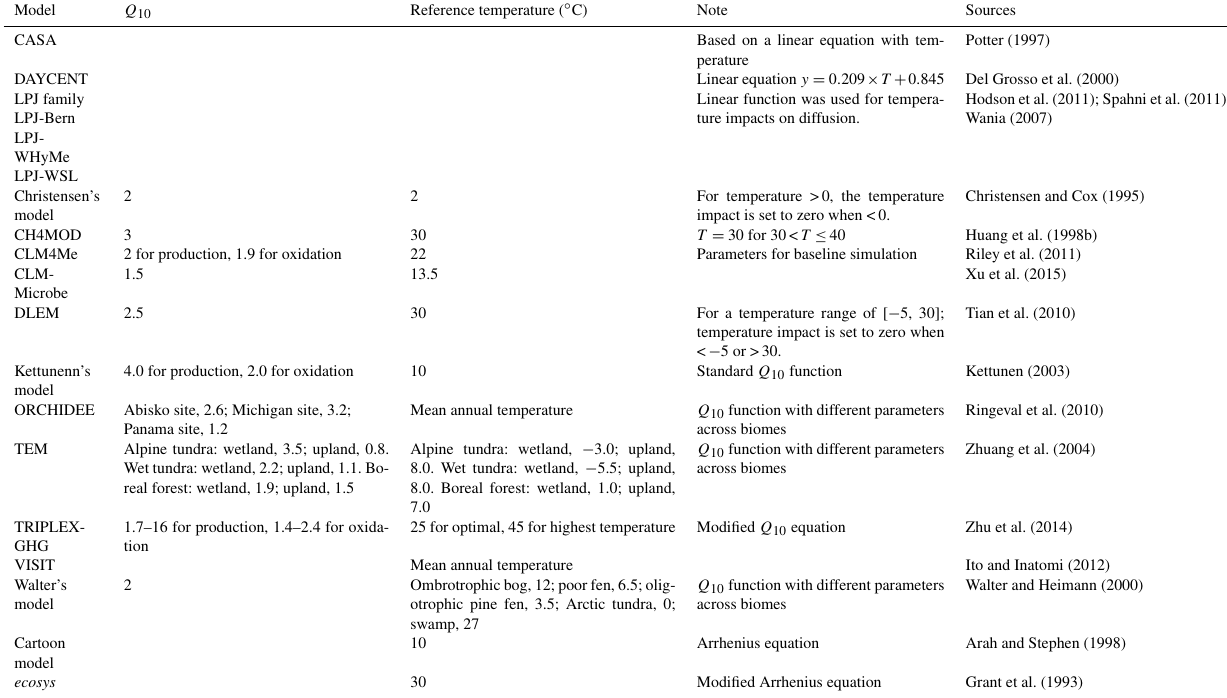
Table 4. Temperature dependence of CH 4 processes in various models (blank indicates the Q 10 function is not used; all temperatures are expressed as ◦ C; 273.15 was used for unit